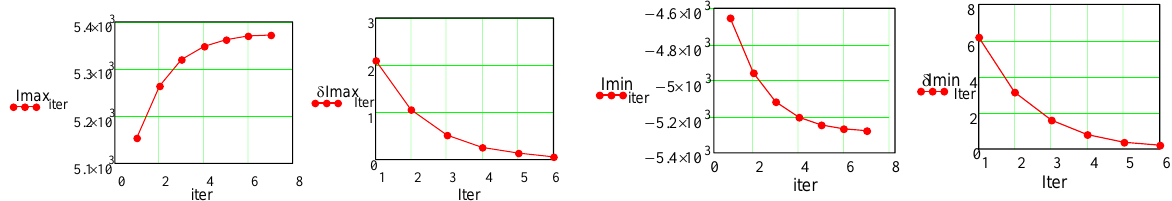
Figure 12. Convergence of the maximum and minimum values of the coil current and relative error.